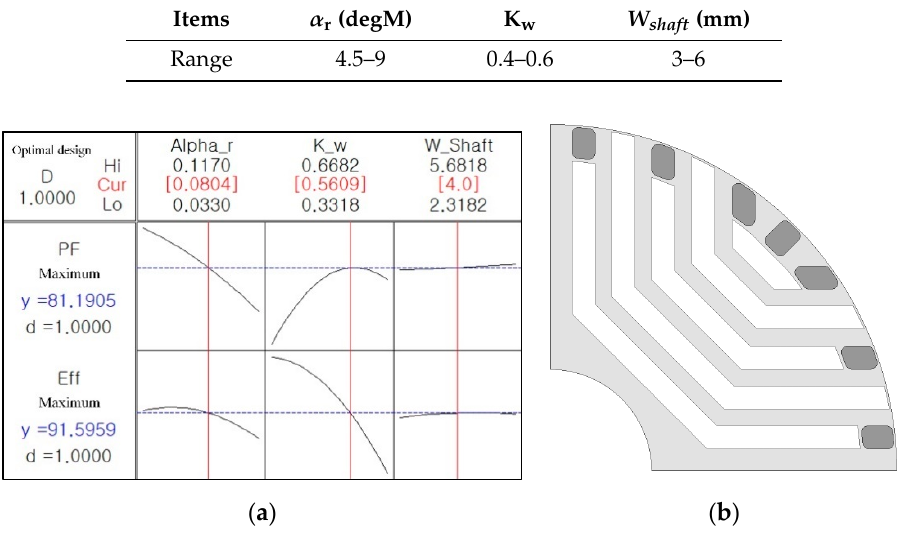
Figure 8. Optimization using RSM under rated current condition. ( a ) RSM result, ( b ) optimal design result. Table 5. Range of design parameters. Table 6. Optimal design result.